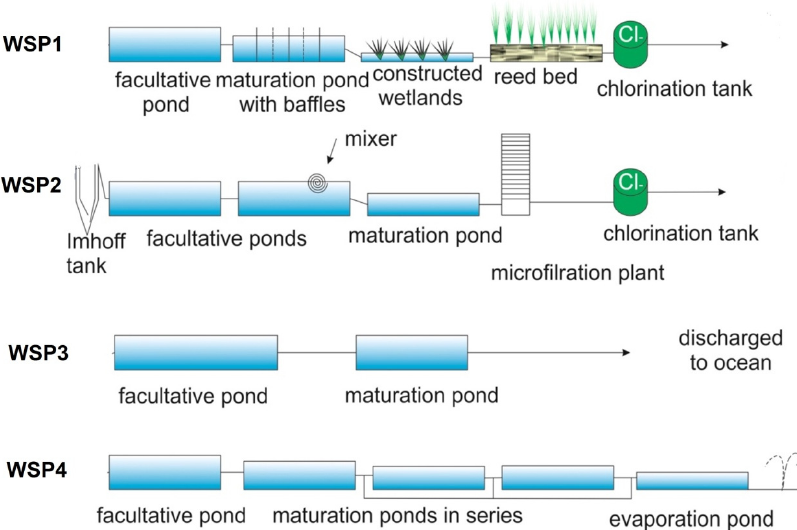
Figure 1. Schematic representation of maturations ponds studied within four different WSP